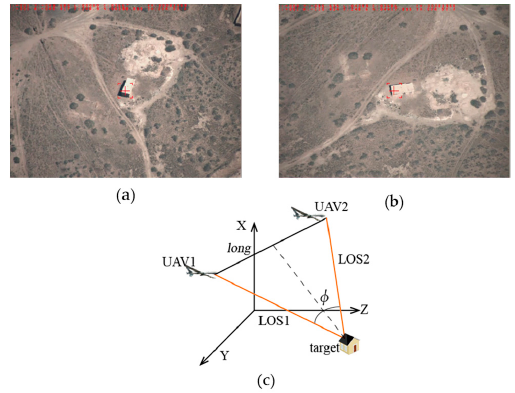
Figure 13. Feature position 1: ( a ) target detection by UAV1; ( b ) target detection by UAV2; and ( c ) positional relationship graph between the two UAVs and the target.